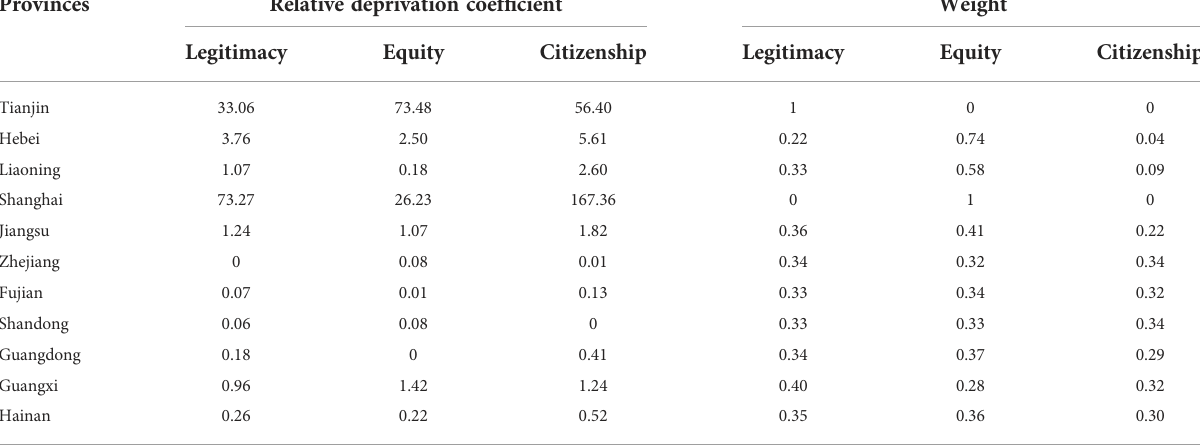
FIGURE 2 Allocation results under the different schemes.